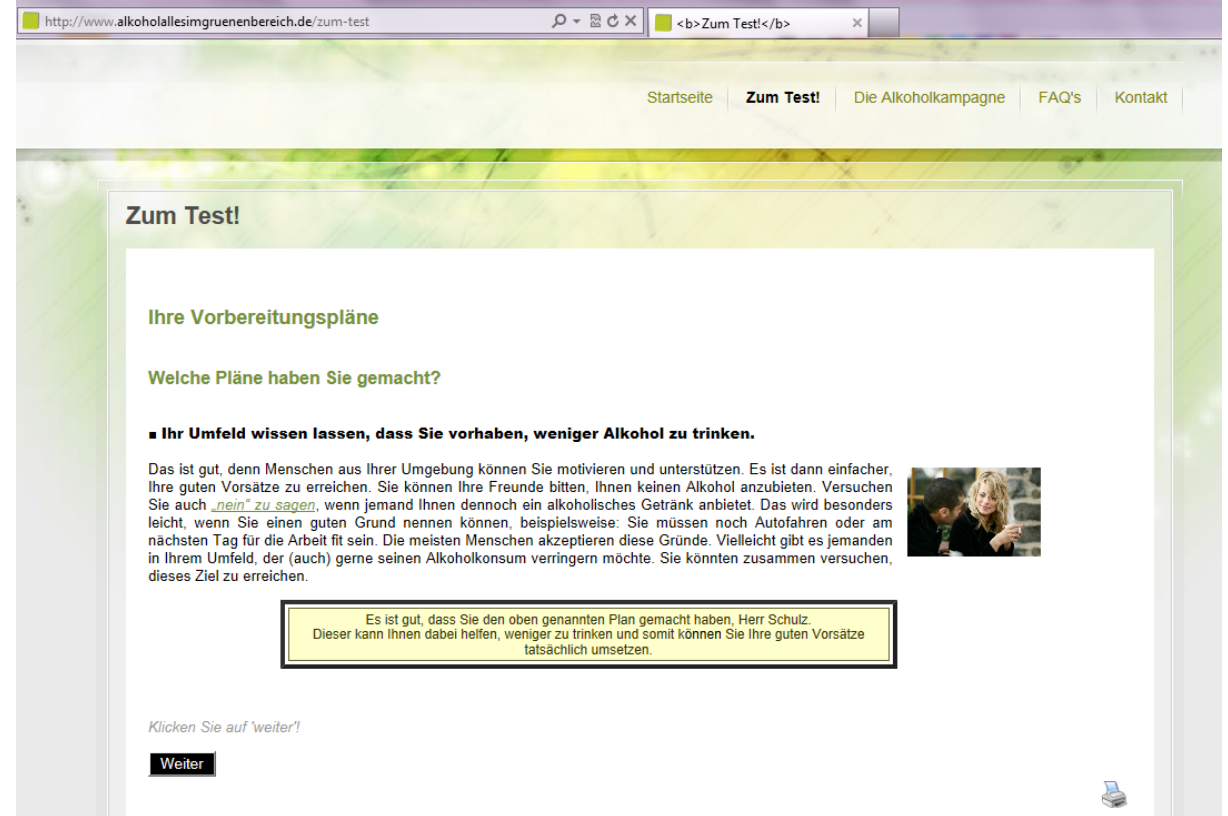
Figure 1. Screenshot of the intervention website, showing personal advice regarding preparatory